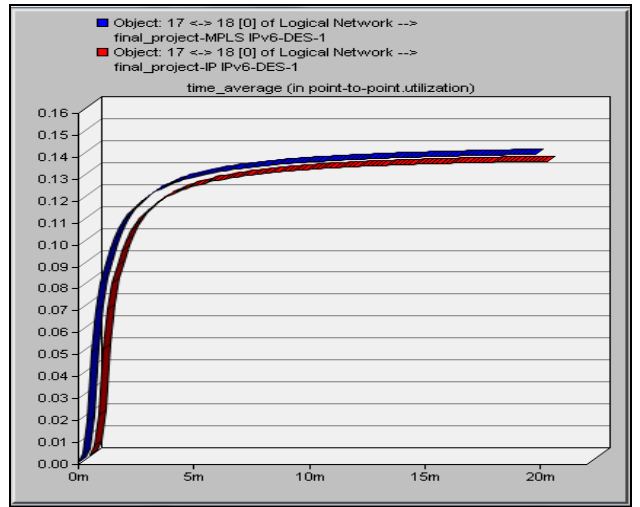
Figure 21 Link Utilization Comparison of IPv6 and MPLS IPv6 along 18 to 19 Link